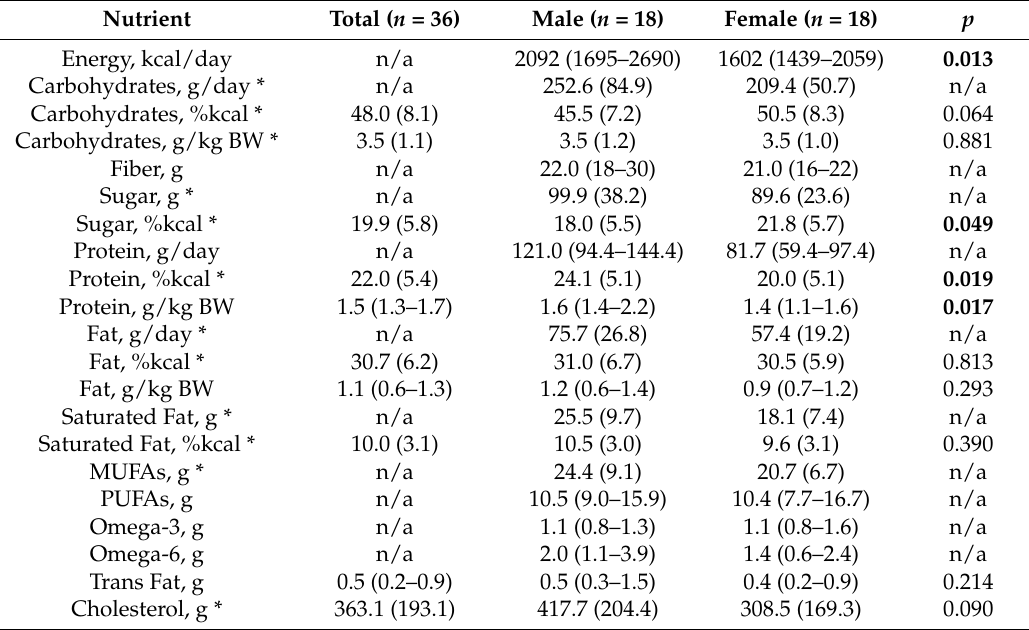
Table 2. Reported energy and macronutrient intakes.